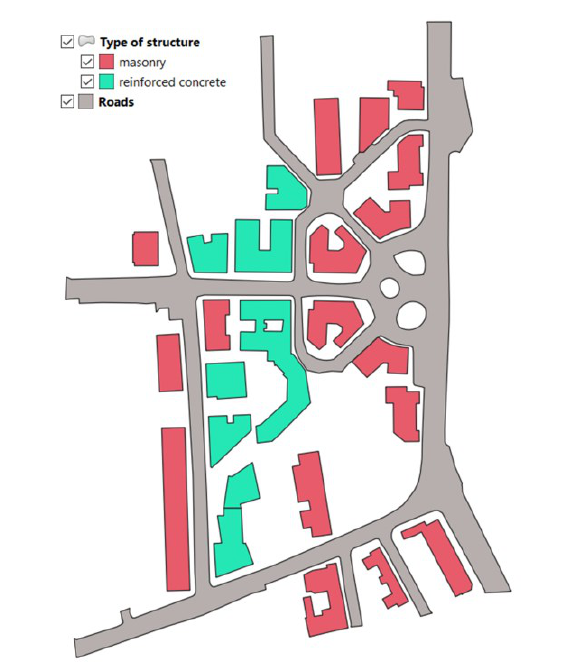
Figure 7. The structures typology of buildings.